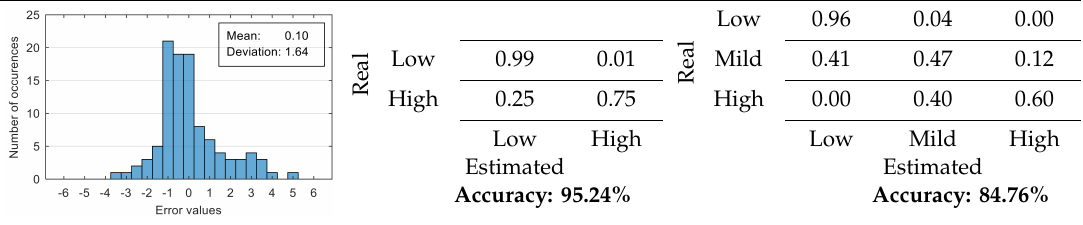
Table 9. Distribution of estimation errors and confusion matrices for levels 2 and 3—using four features.